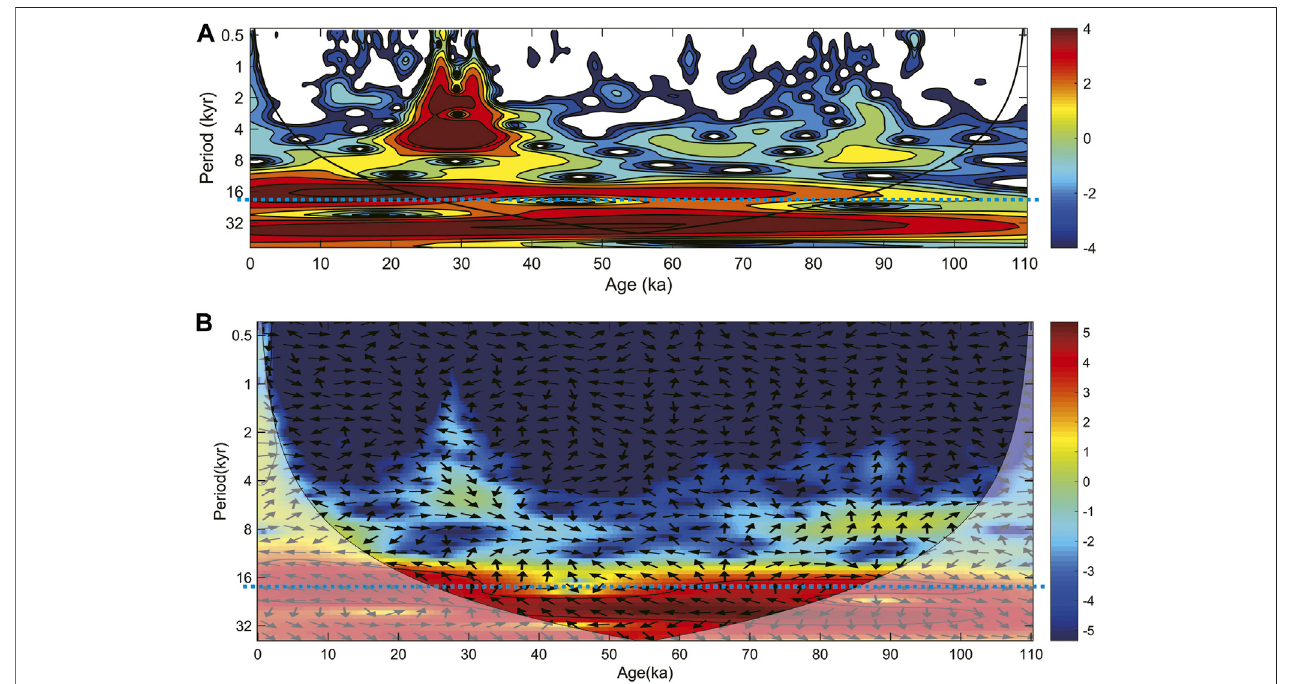
FIGURE 6 | (A) Continuous wavelet transform analysis of IRD (vol%) in core LV55-40-1 and (B) Cross-wavelet analysis of IRD (vol%) in core LV55-40-1 and SON- insolation. Blue dashed lines represent main orbital cycle of 20-kyr.